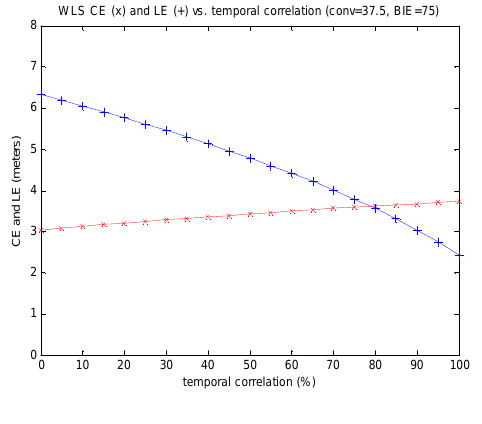
Figure 8. Predicted LE and CE vs. temporal correlation (baseline imaging geometry)